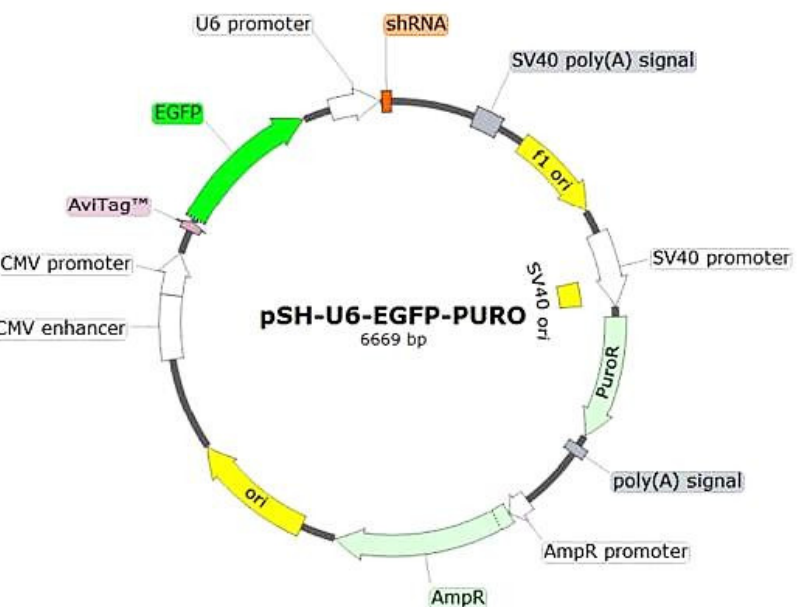
Figure 2. Plasmid for downregulation from Creative biogene.